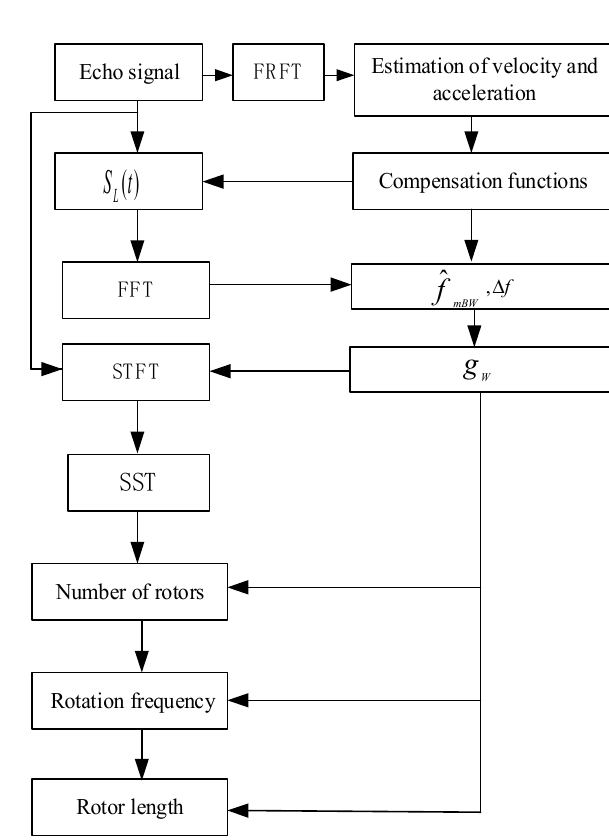
Figure 3. The processing flow of proposed algorithm.